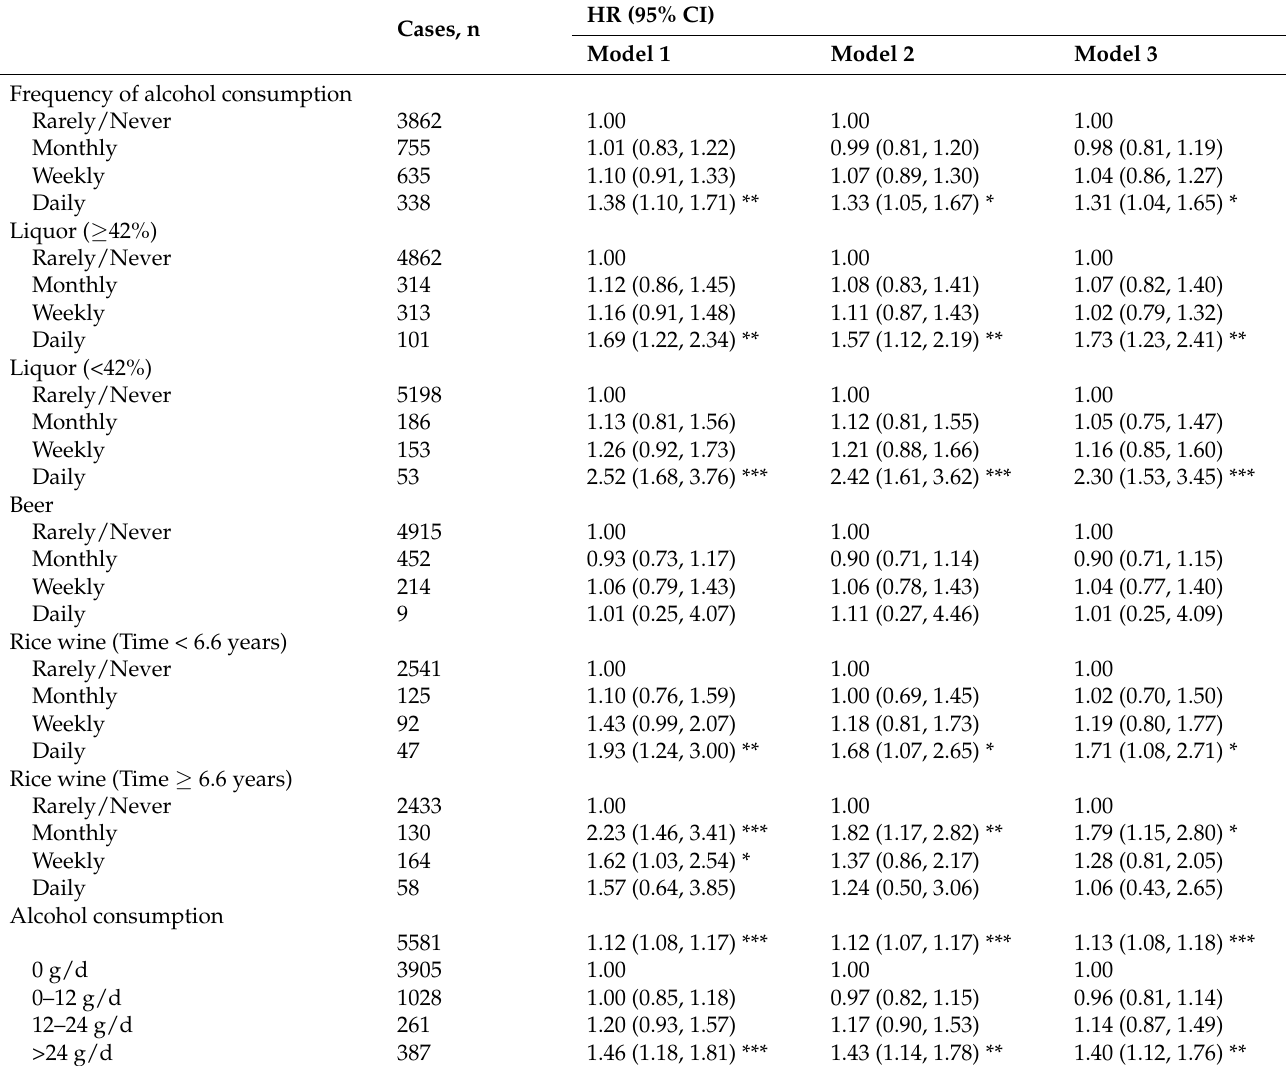
Table 5. Hazard ratios (95% confidence intervals) of hypertension associated with drinking after excluding new cases of hypertension within one year of follow-up.